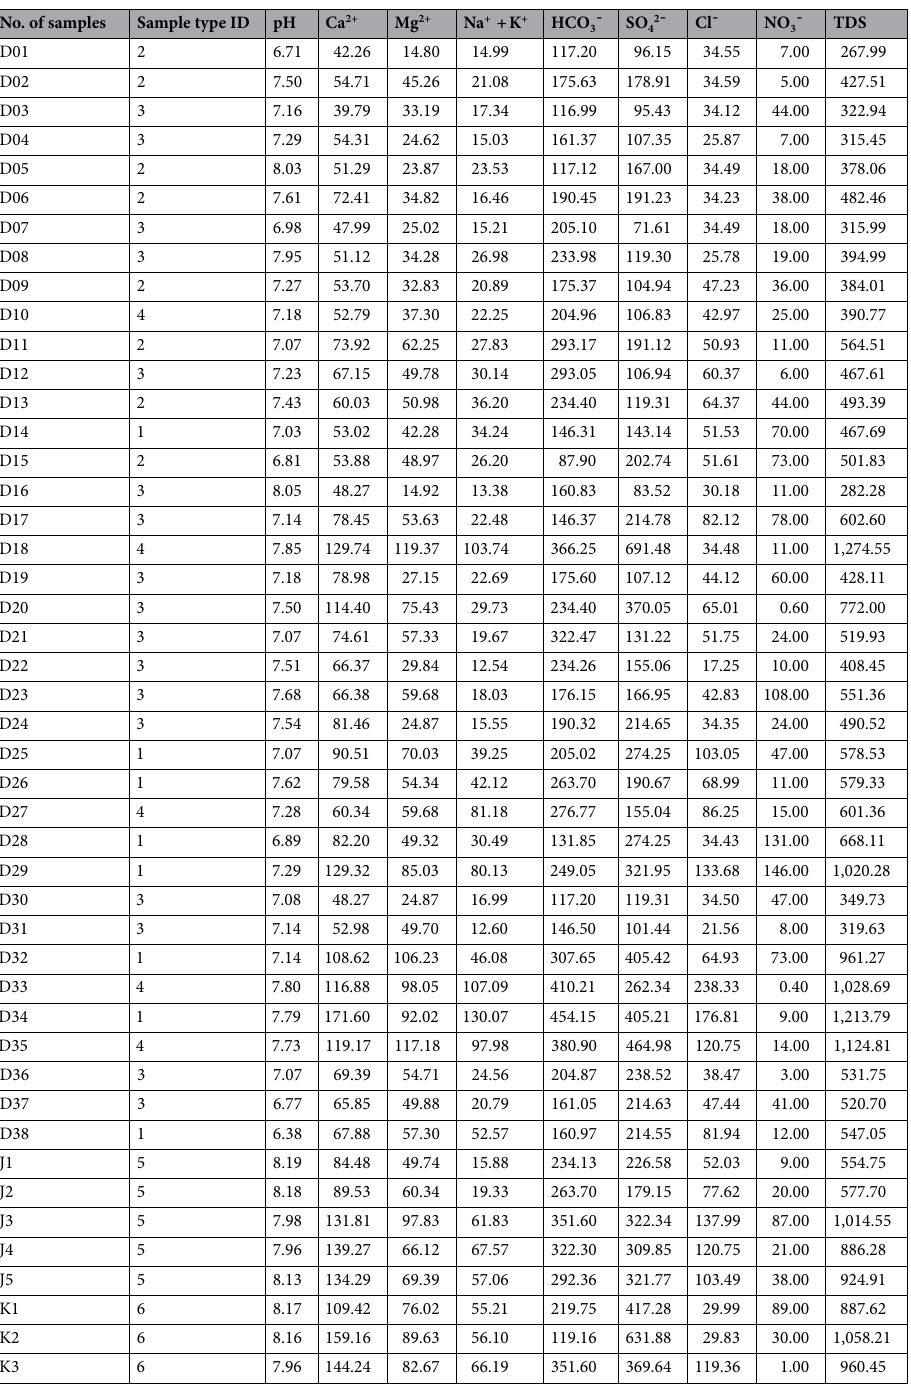
Table 1. The analysis results for water samples in the study area (all hydrochemical compositions are in units of mg/L except for pH). Sample type ID: 1-Alluvial pore aquifer, 2-Eluvium pore aquifer, 3-Bedrock